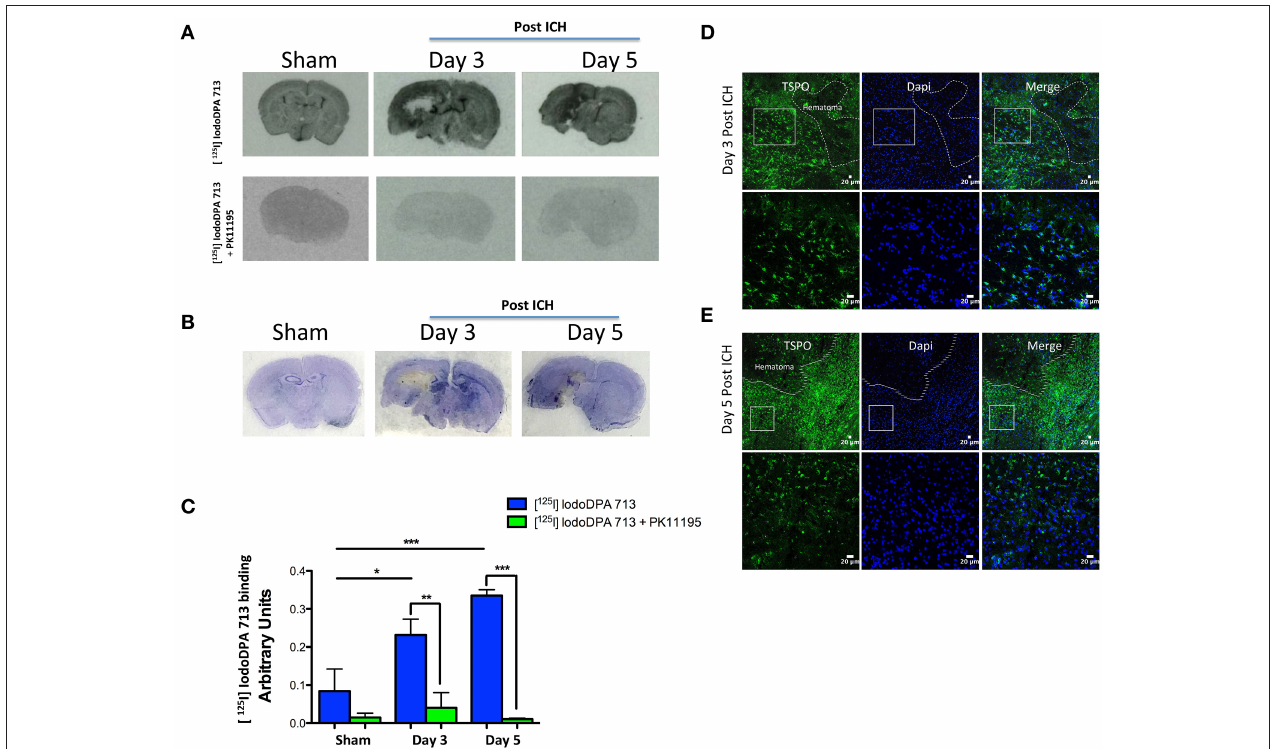
FIGURE 1 | (A) Representative autoradiography images demonstrating the binding of [ 125 I]IodoDPA-713 to the brain sections from sham or ICH (top panel). PK11195 inhibited the binding of [ 125 I]IodoDPA-713 to the brain sections (bottom panel) ( n = 3 mice/group). (B) Brain sections adjacent to the ones as depicted in (A) were subjected to cresyl violet staining and it demonstrates that the [ 125 I]IodoDPA-713 uptake was observed mostly in the ipsilateral striatum after ICH ( n = 3 mice/group). (C) The quantification of [ 125 I]IodoDPA-713 binding to brain sections as assessed by estimating the optical density using image J (NIH, USA). * p < 0.05, ** p < 0.01, *** p < 0.001 vs. control ( n = 3 mice/group). Brain sections ( n = 3 mice/group) were subjected to immunostaining further illustrates that the [ 125 I] IodoDPA-713 binding was observed in brain regions with enhanced TSPO expression after 3 days post-ICH (D) and 5 days post-ICH (E ) and the dotted line demarcates the hematomal and peri- hematomal brain